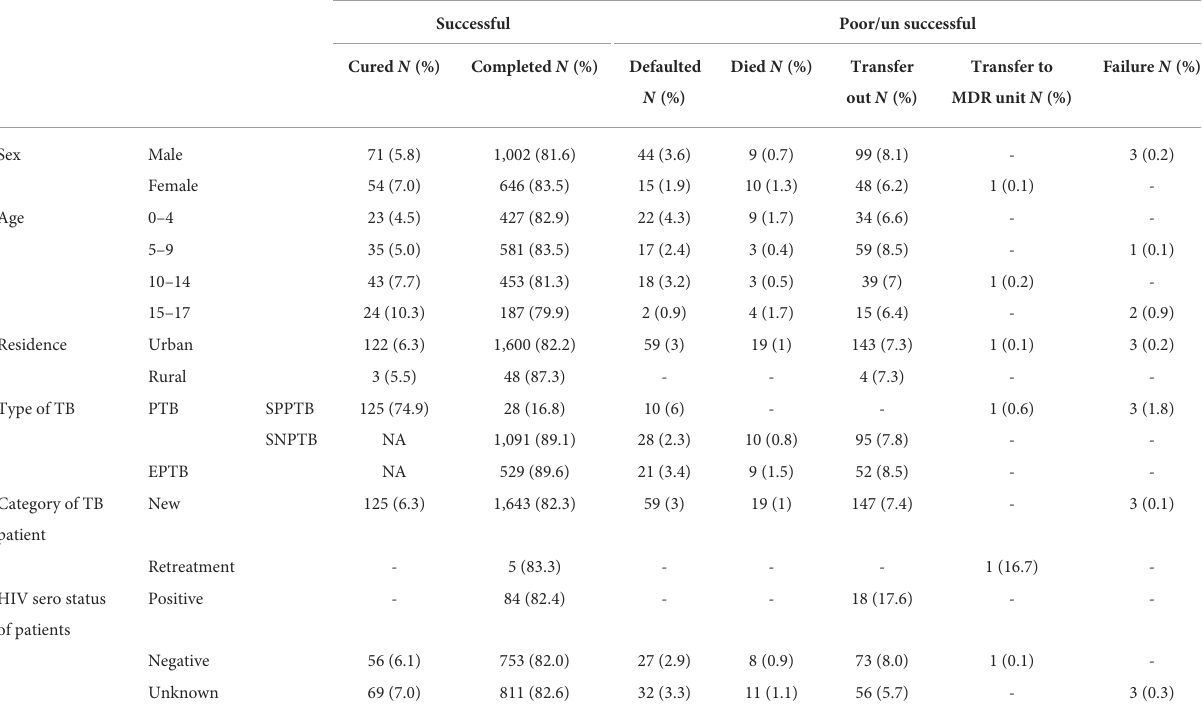
TABLE 3 Treatment outcome by socio-demographic characteristics and types of tuberculosis among children TB patients attending treatment in selected health institutions of eastern Ethiopia, 2017 ( n = 2,002). Variable